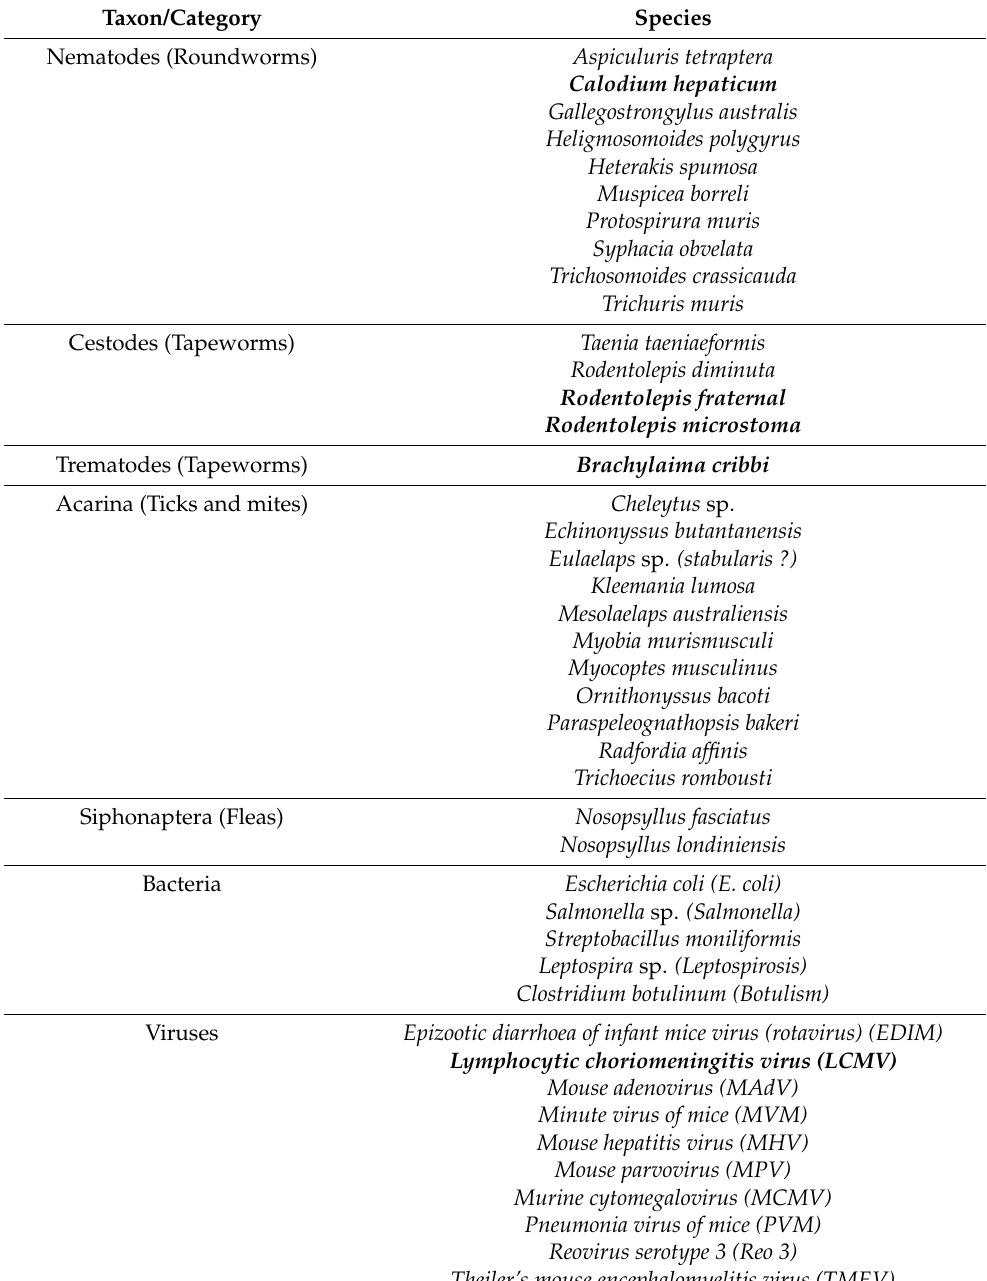
Table 1. Summary of parasites, bacteria, and viruses recorded in wild populations of house mice ( Mus musculus ) in Australia. The parasites in bold are potential human pathogens. Source: modified from Singleton and Krebs [9] and references